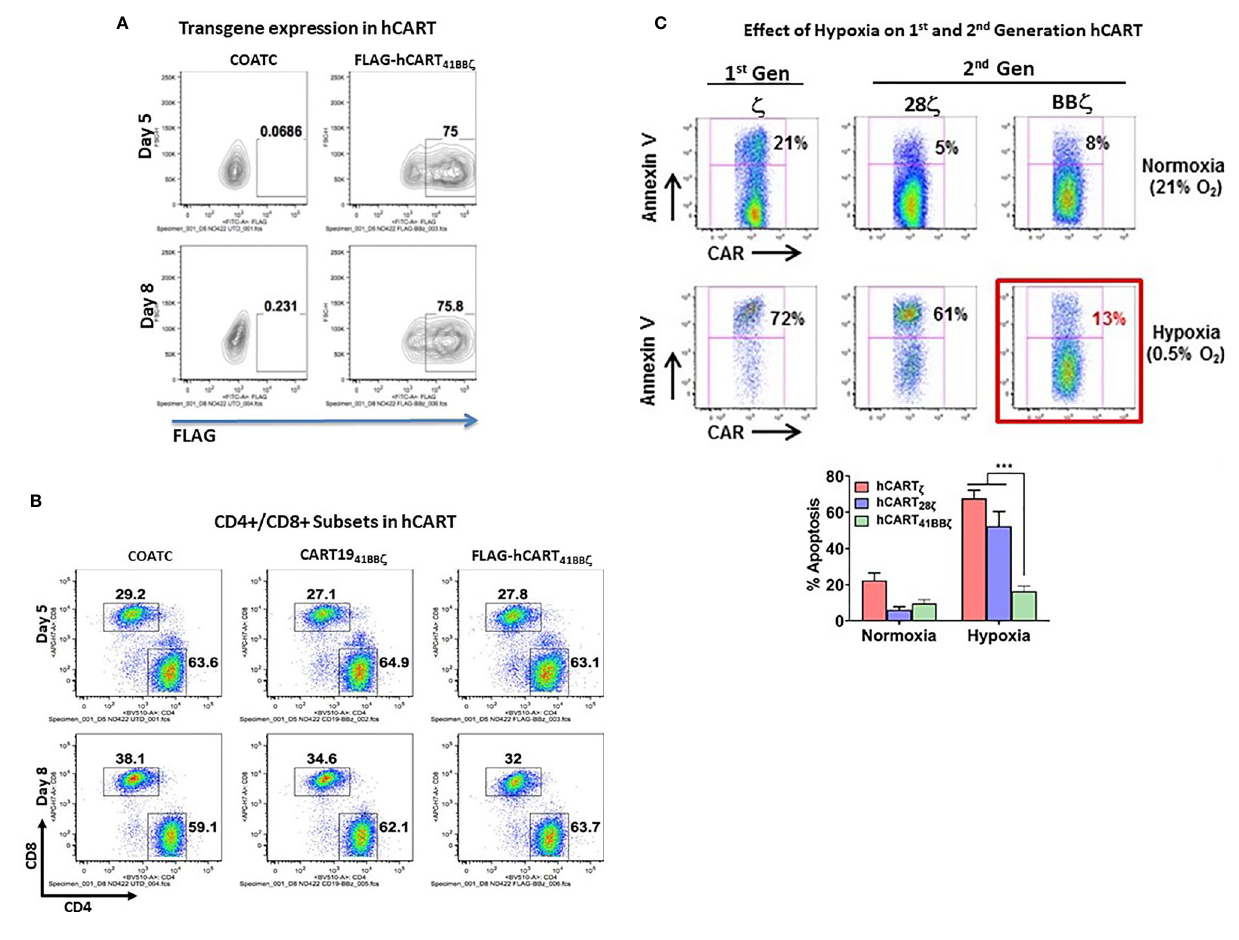
FIGURE 3 | (A) Transduction Ef fi ciency of COACT. Representative data from COATC with 41BB z intracellular domain ( hCART 41BB z ) show 75% transgene expression (detected by anti-FLAG antibody) on day fi ve and day eight. (B) CD4 and CD8 T cell Subsets in hCART. The CD4/CD8 T cells ratio in hCART 41BB z , CD19 41BB z CAR-T cells and untransduced T cells (COATC) on day fi ve and day eight suggest no change in CD4/CD8 T cells ratio due to transgene insertion including transduction of COATC with different intracellular signaling domains. (C) hCART 41BB z are Resistant to In Vitro Hypoxia Effectors. Showing that hypoxia differentially affected survival of hCART depending on the co-stimulatory endodomain. Headless CAR T cells with z alone (hCART z ) or CD28 z endodomain (hCART 28 z ) showed 72% and 61% apoptosis under hypoxia, respectively, whereas hCART 41BB z showed just 13% apoptosis under hypoxic (0.5% oxygen) condition. Lower panel shows signi fi cantly less (p<0.0003) apoptosis of hCART 41BB z compared to hCART z or hCART 28 z under hypoxic condition. Data is presented as mean ± SD of 3 experiments and analyzed using Two-way ANOVA and Turkey ’ s multiple comparisons test (***p <